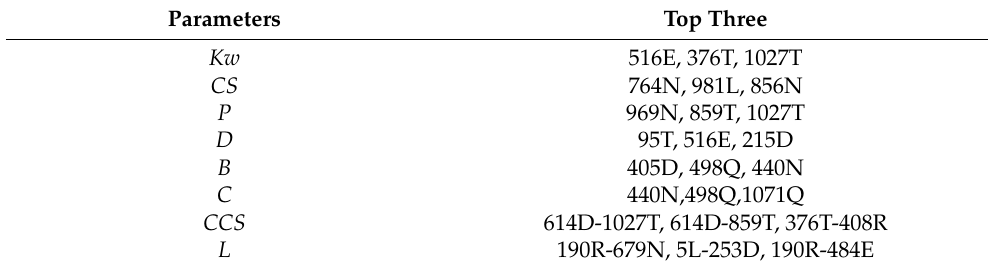
Table 1. The top three substitutions and co-substitutions with the highest network characteristics.